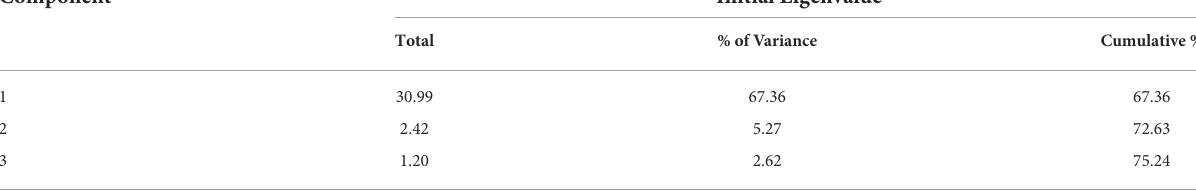
TABLE 3 Selected analysis results using varimax rotation and principal component